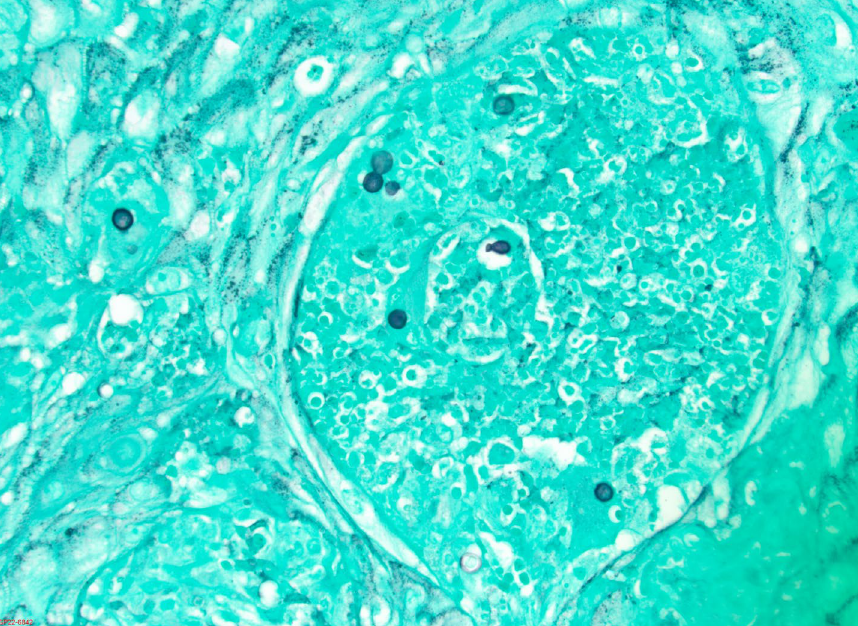
Figure 1. Grocott methenamine silver stain of biopsy of an exophytic lesion on the face of a middle- aged man. Thick-walled yeasts approximately 8–10 µm in diameter, one of which shows broad-based budding typical of B. dermatitidis , are seen (20× magnification).